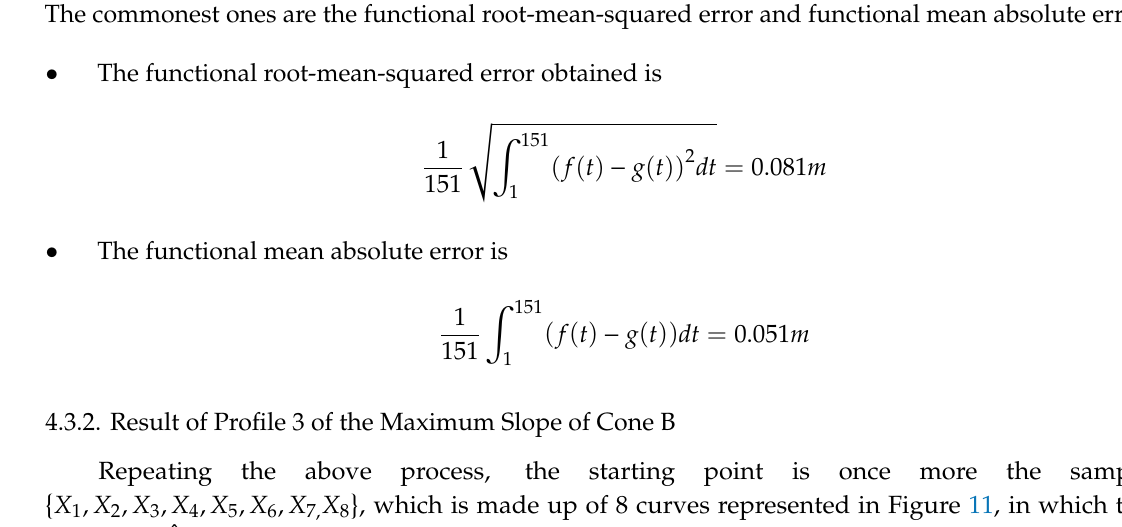
prediction ˆ X 9 obtained appears in red.